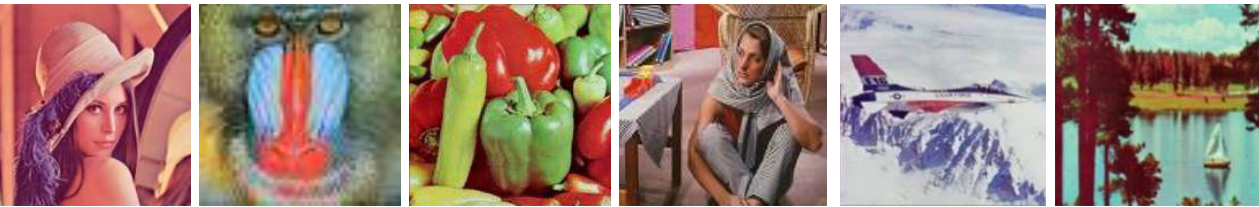
Figure 3. Cover image samples used in experimentation with sizes 512 × 512 and 256 × 256.